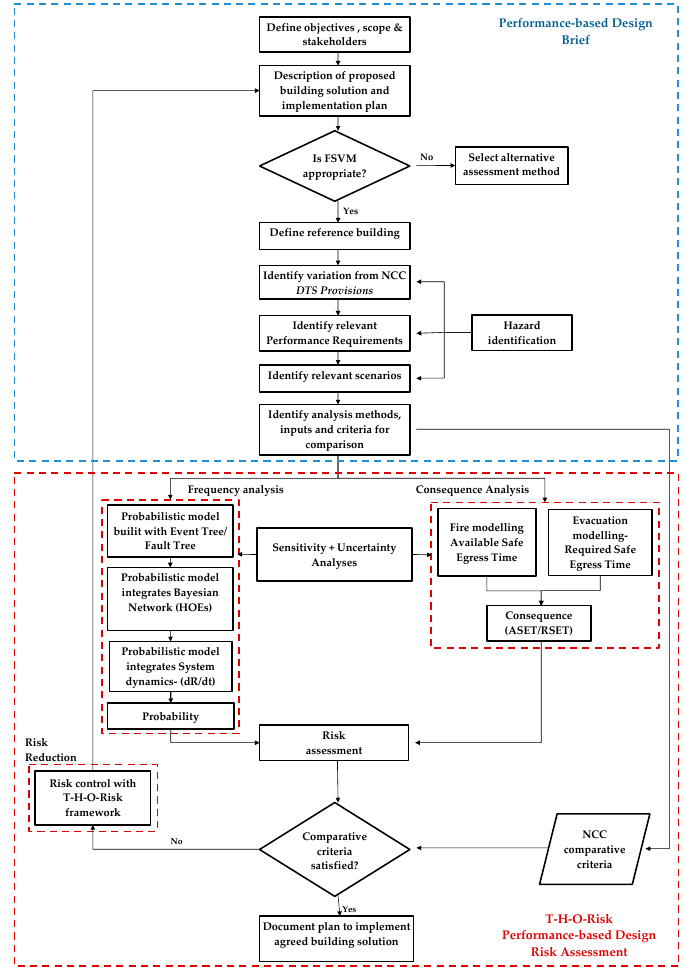
Figure 1. Technical-Human-Organizational Risk (T-H-O-Risk) FSVM (fire safety verification method) process flow chart. NCC: National Construction Code.